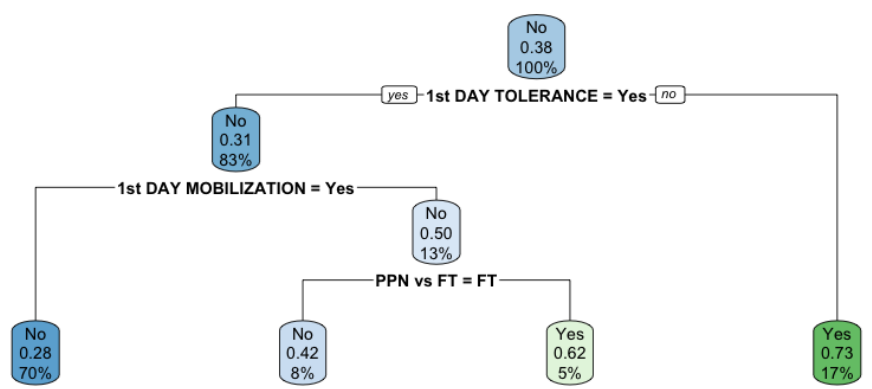
Figure 3. Recursive partition decision tree using Complication “Yes-No” as a response variable with Categorical Variables Related to the Patient. Green color complication and Blue color Non- complication. The left branches represent the subjects who complain about the categorical variable level presented, the right branches represent non-compliance of the categorical level presente in the